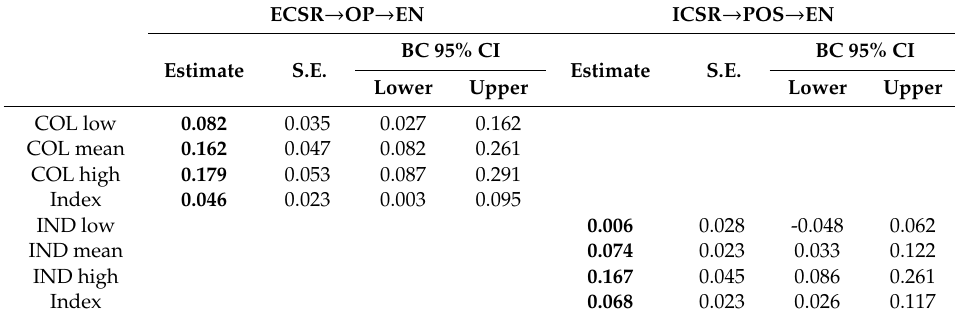
Table 5. Moderated mediation